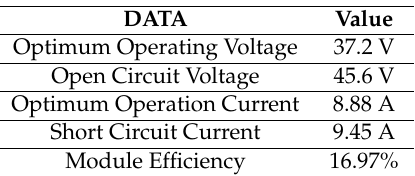
Table 1. CS6U-330P Electrical